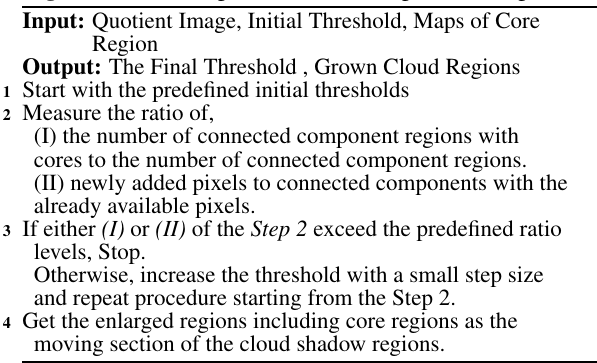
Algorithm 1: Moving Cloud Shadow Region